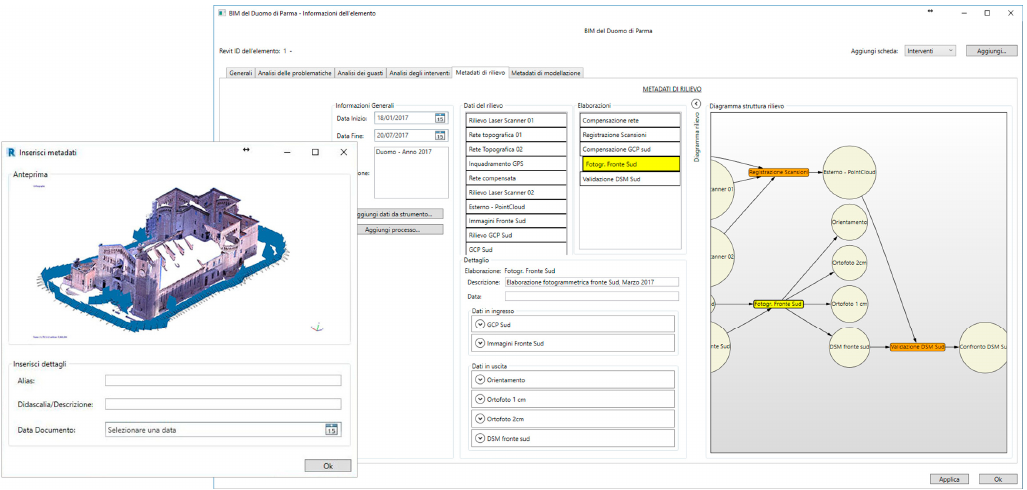
Figure 6. GUI for survey metadata